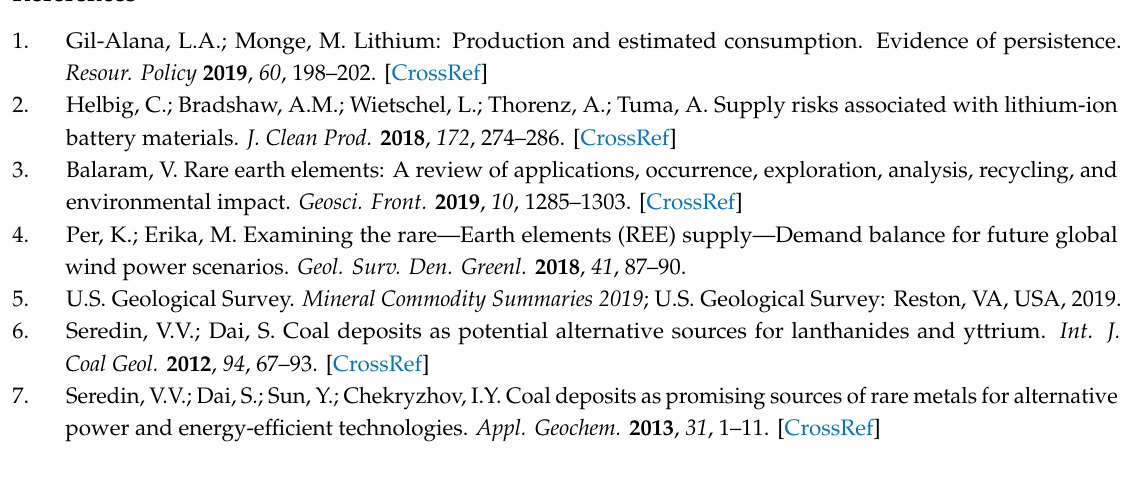
Figure 12. Evaluation of REY in the coal ashes, roof and floor samples in the Donggou